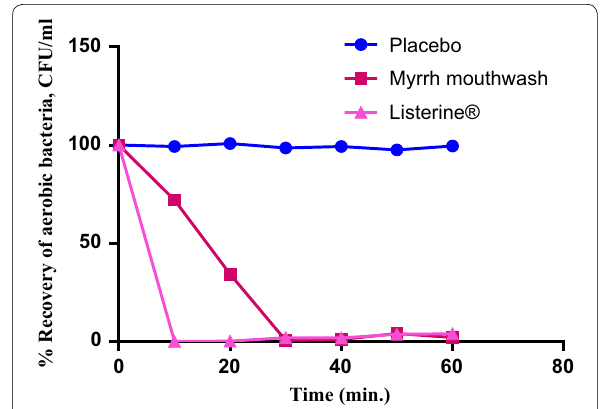
Fig. 1 In vitro antibacterial activity of Myrrh mouthwash (5% v/v) compared to placebo and Listerine